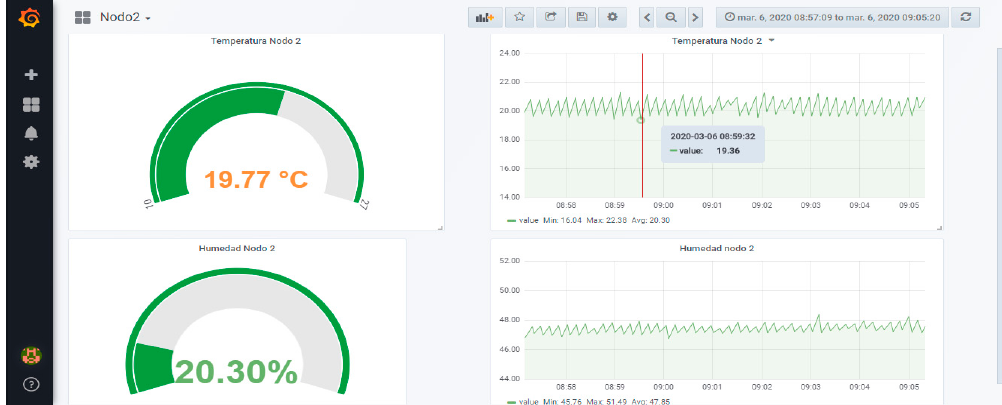
Figure 6. ( a ) Wireless sensor node monitoring environmental data, ( b ) wireless sensor nodes and their internal structure.